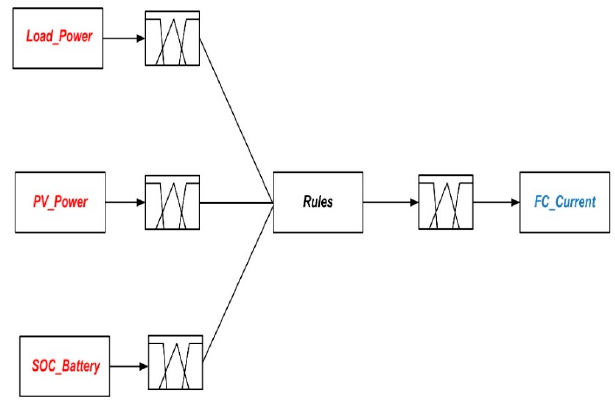
Figure 21. The fuzzy inference system (FIS) function configuration.